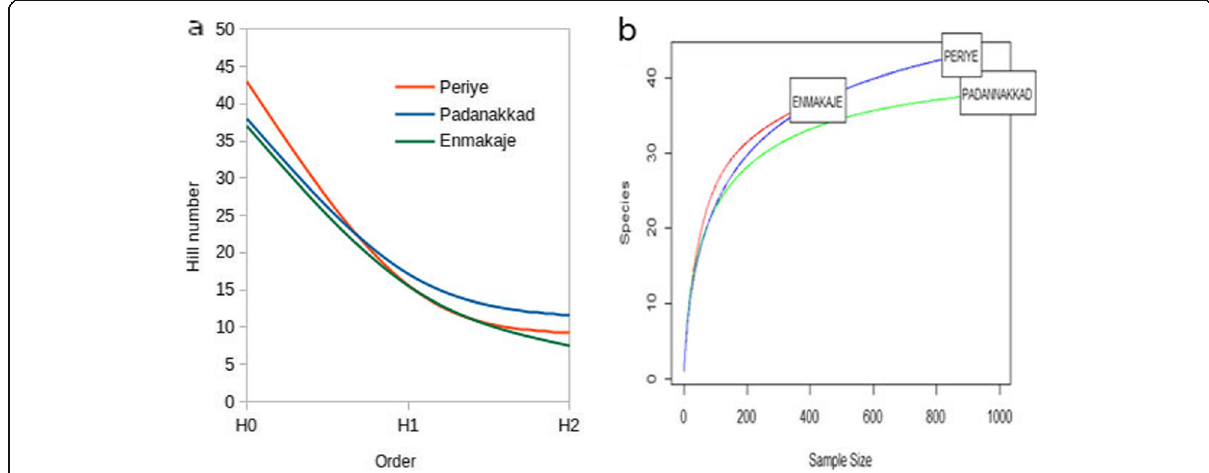
Fig. 4 a Diversity profile curve; diversity curves of the cumulative assemblage of each transect type (Hill ’ s number of order 0 is species richness, 1 is the exponential of Shannon ’ s entropy, and 2 is the inverse of Simpson ’ s concentration). b Rarefaction curve of each butterfly assemblages for the given number of samples as a